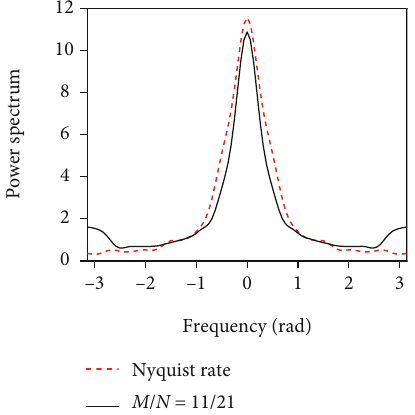
Figure 8: Estimated power spectrum of the length-21 AR signal using both Nyquist rate and sub-Nyquist rate ( M / N = 11/21 ). Smoothed spectrum is achieved by zero padding and interpolation. SNR = 30 dB